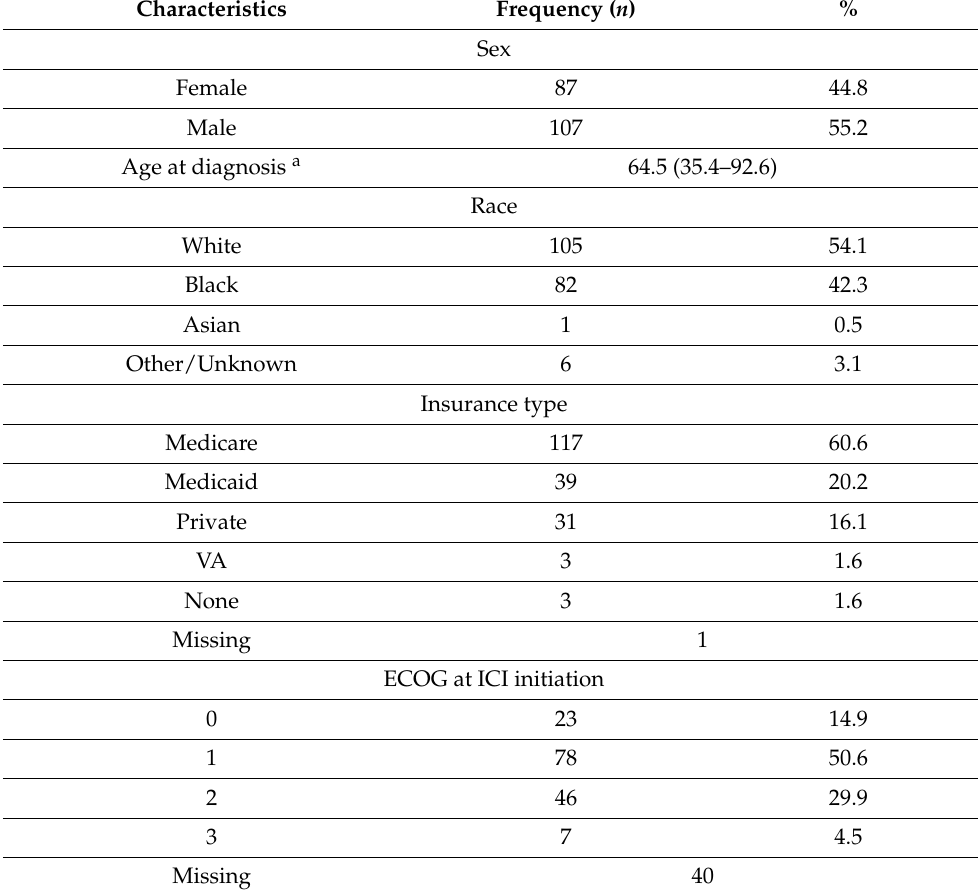
Table 1. Demographic Characteristics of Stage IV NSCLC Patients ( n =